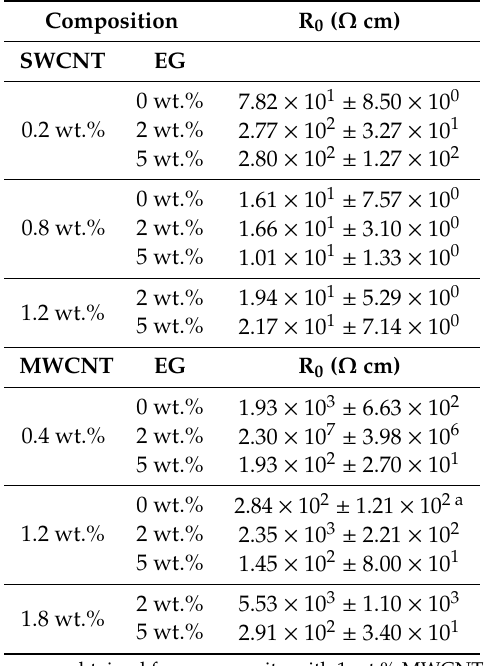
Table 1. Electrical volume resistivity of the composites containing multiple carbon nanomaterials.